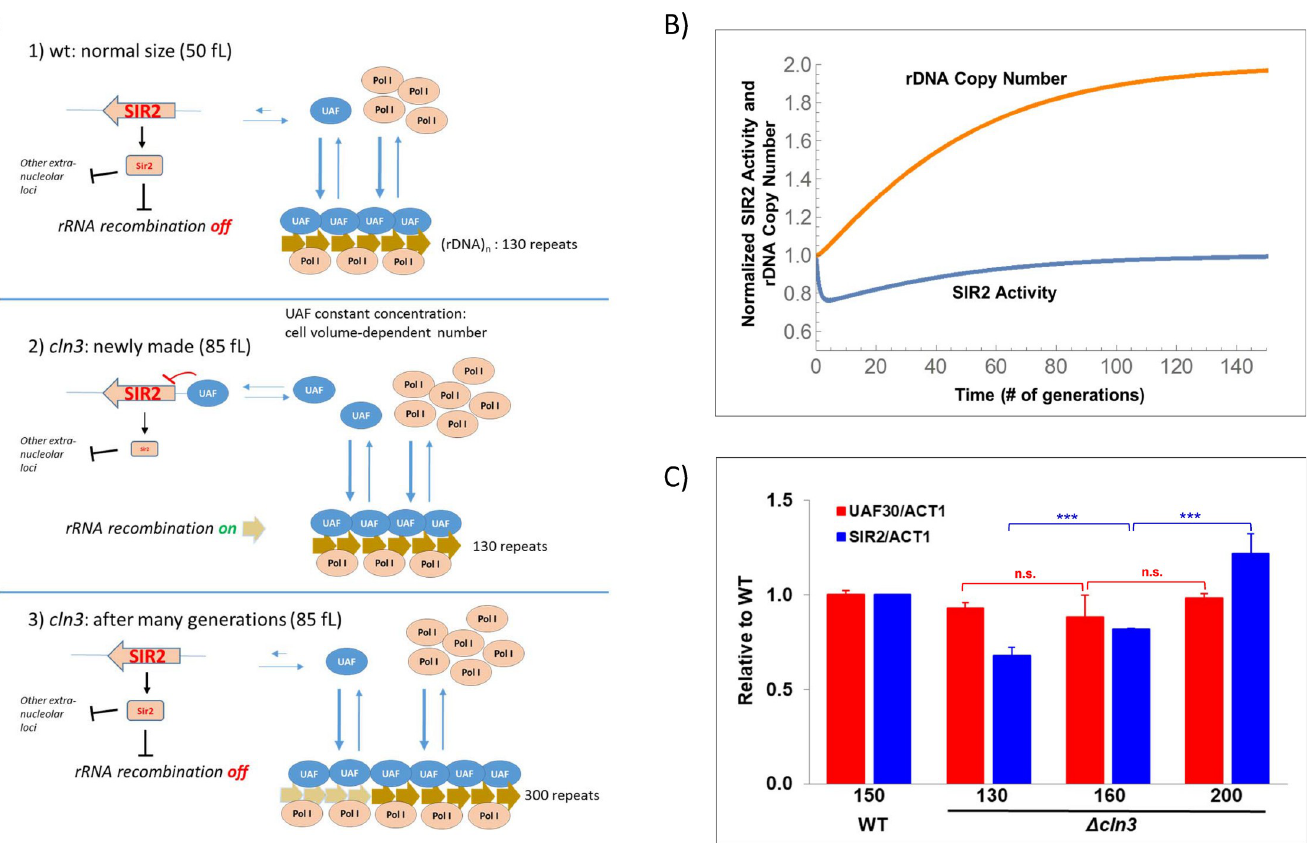
Fig 4. Model for rDNA copy number regulation by cell volume. A) A cartoon model for cell size control on the rDNA repeat copy number is shown (see the main text for details). B) A mathematical model (see S1 Appendix) predicts that the Sir2 activity (blue line) suddenly decreases after cell enlargement in cell that becomes Δ cln3 and that progressively recovers in parallel to the increase in rDNA copy number that results from the increased recombination at the rDNA locus and the selection for higher copy number successive generations. C) The relative levels of UAF30 and SIR2 to a reference gene ( ACT1 ) in the cln3 strains of different numbers of generations and repeats (130, 150, 200) during the evolution experiment determined by RT-qPCR are shown. Bars are relative to the value a wild type (strain 1b S1 Table, WT, 150 repeats) used as a reference. The x axes reveal the rDNA copy number of the different strains used. A t-test was used for statistical significance: n.s. (not significant), ��� : p-value <